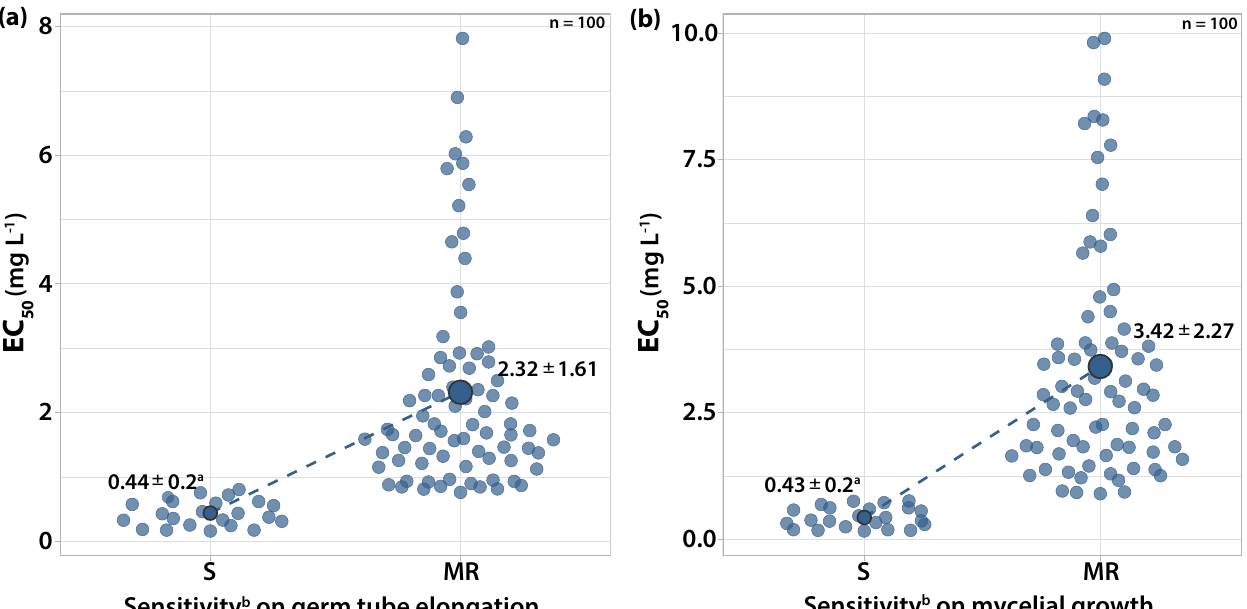
Figure 2. Frequency of sensitivity distribution for one hundred V. inaequalis isolates to trifloxystrobin on ( a ) germ tube elongation and ( b ) mycelial growth. The mean EC 50 values for the resistant population of V. inaequalis were significantly higher ( p < 0.05) than the mean EC 50 values of the sensitive population on both tests according to the Welch’s t-test. a Average values of sensitive isolates ± standard deviation; circle size reflects the population number. b Sensitivity groups: S, sensitive; R, resistant.